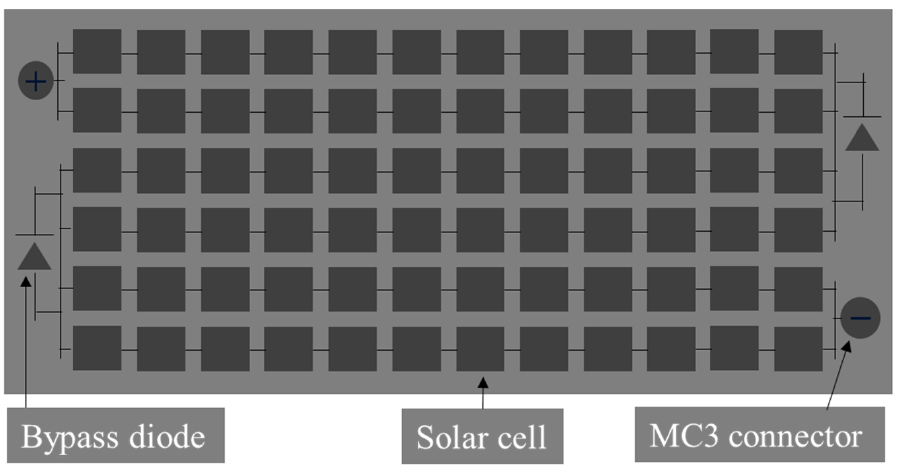
Figure 1. Electrical layout of the field-aged PV modules. Three serially circuited substrings; each consisting of a pair of 12 series connected solar cells in 3 series connected substrings.